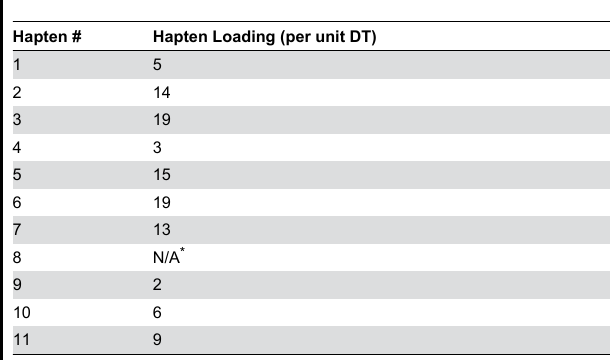
1. Hapten Loading of Different Hapten-DT Conjugates.